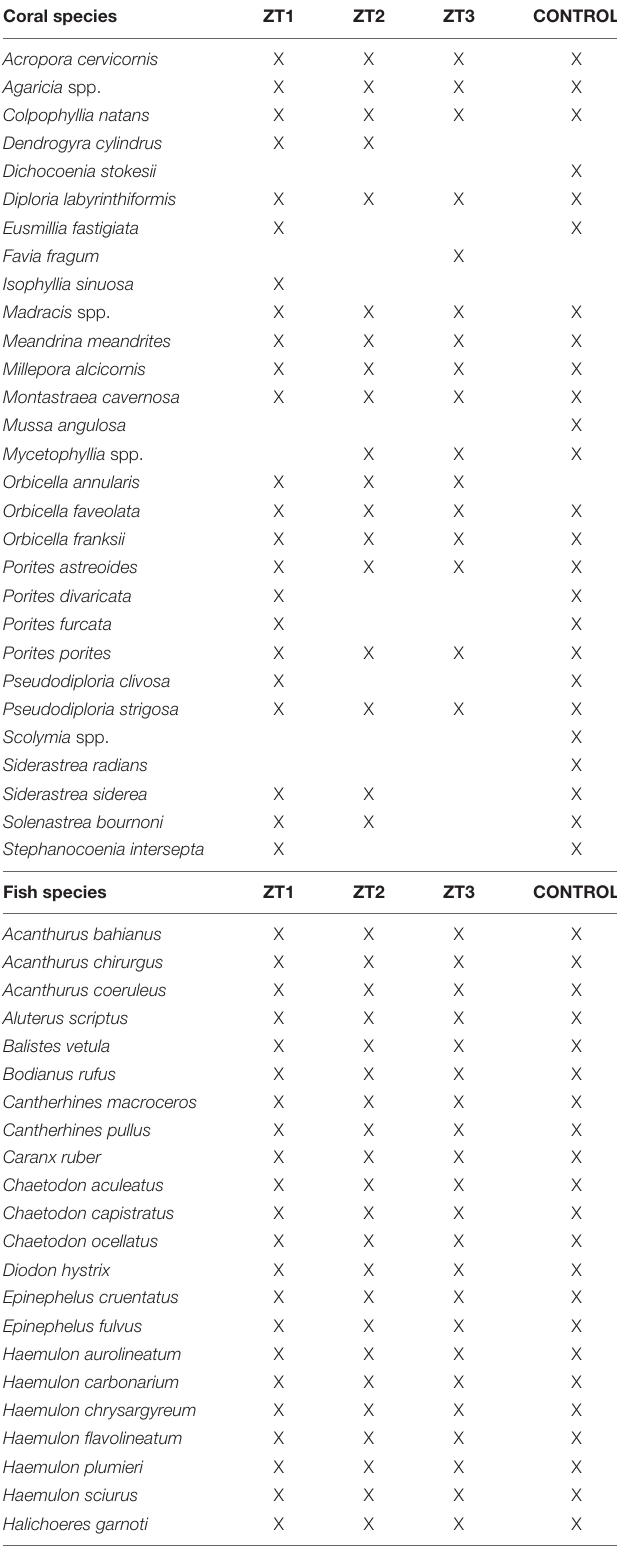
TABLE 2 | Coral and fish species observed in the three outplanting sites and control